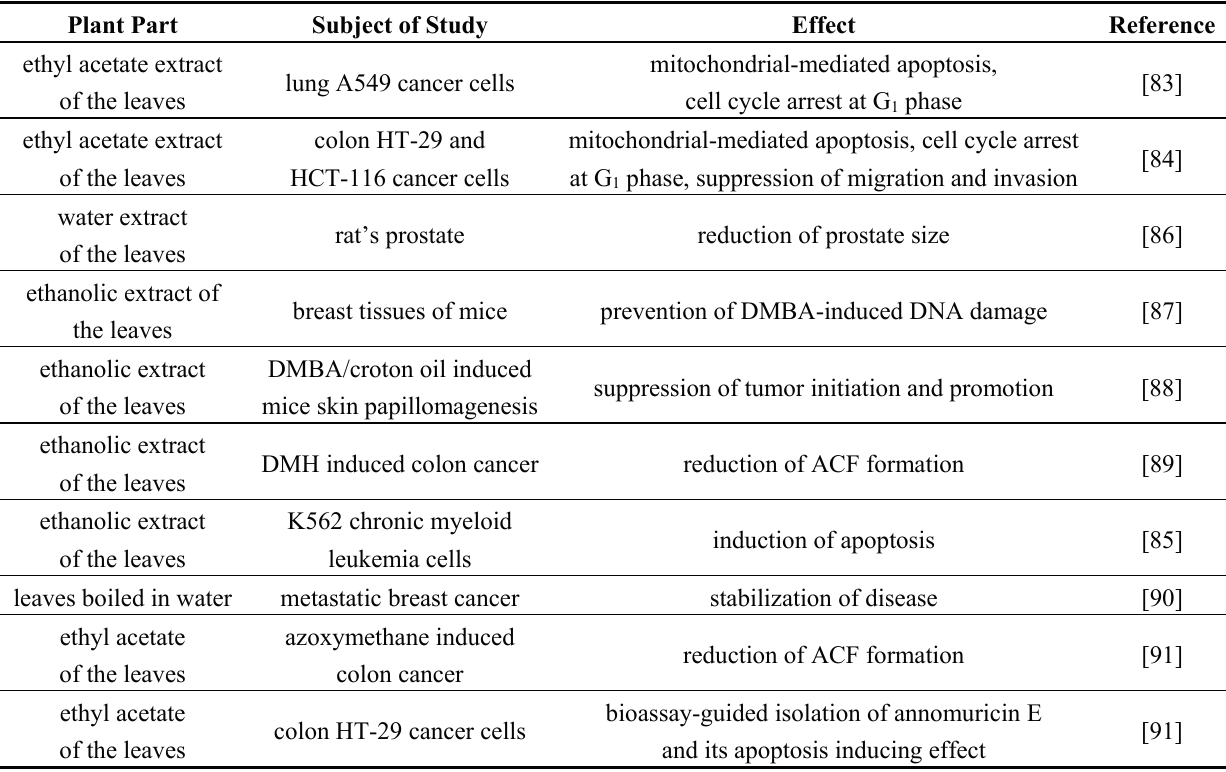
Table 2. Anticancer studies on A. muricata